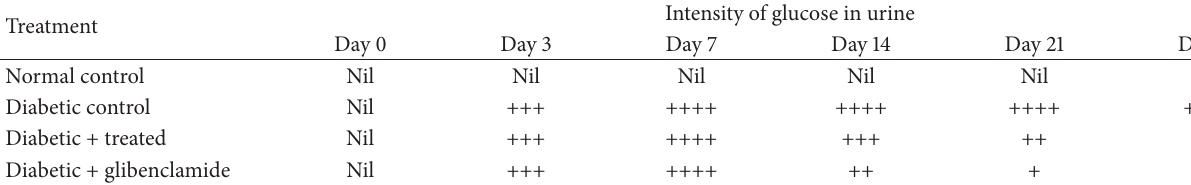
Table 5: Effect of Triticum aestivum on the HbA1C and liver glycogen level in streptozotocin-induced diabetic rats. Treatment HbA1C Liver glycogen (mg/g) Normal control Diabetic control